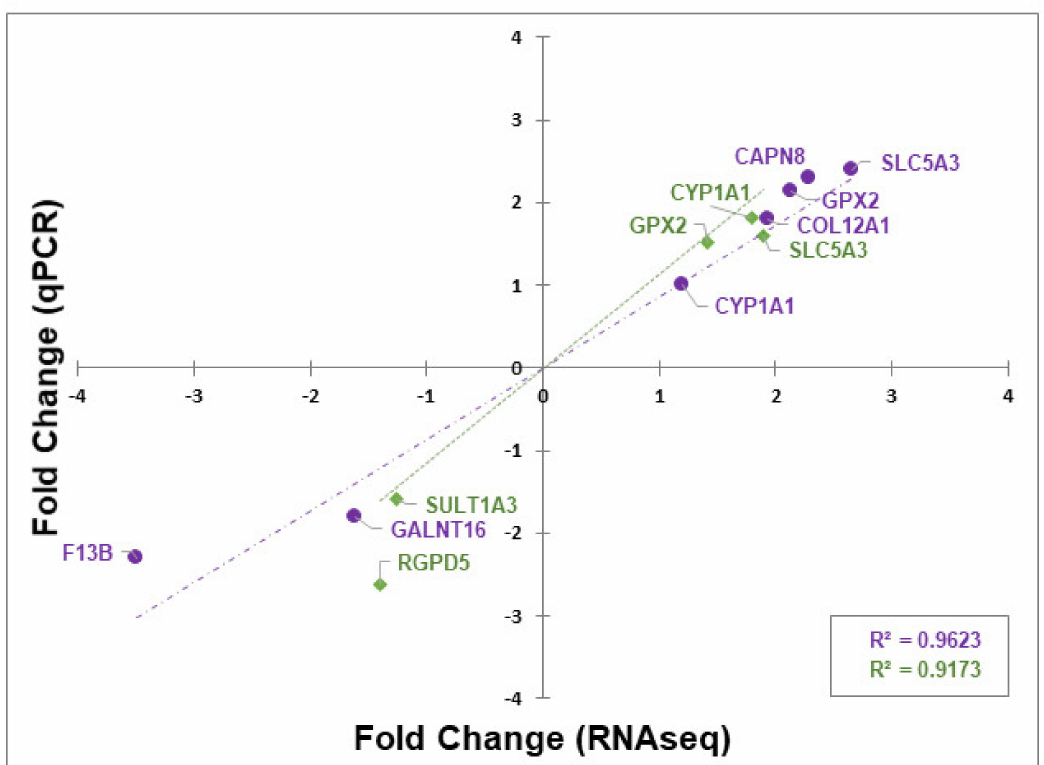
Figure 4. Validation of RNA-seq by RT-qPCR. The abscissa represents RT-qPCR Fold Change in gene expression, the ordinate represents RNA-seq Fold Change in gene expression. • GOS gene expression; −·−· GOS gene expression linear trend line; (cid:7) FOS gene expression; ... . FOS gene expression linear trend